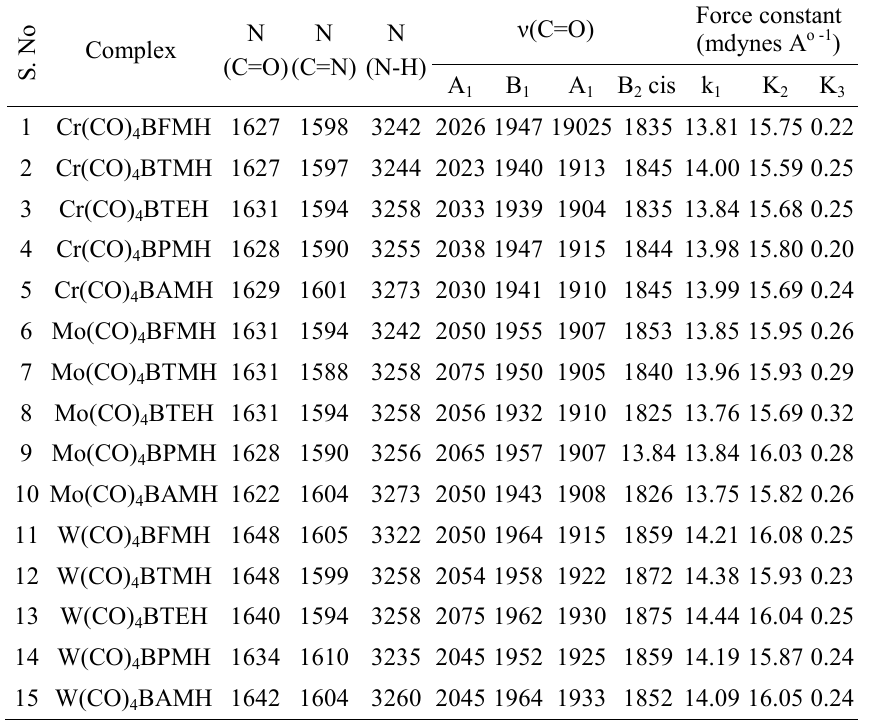
(L-L)] Complexes. 4